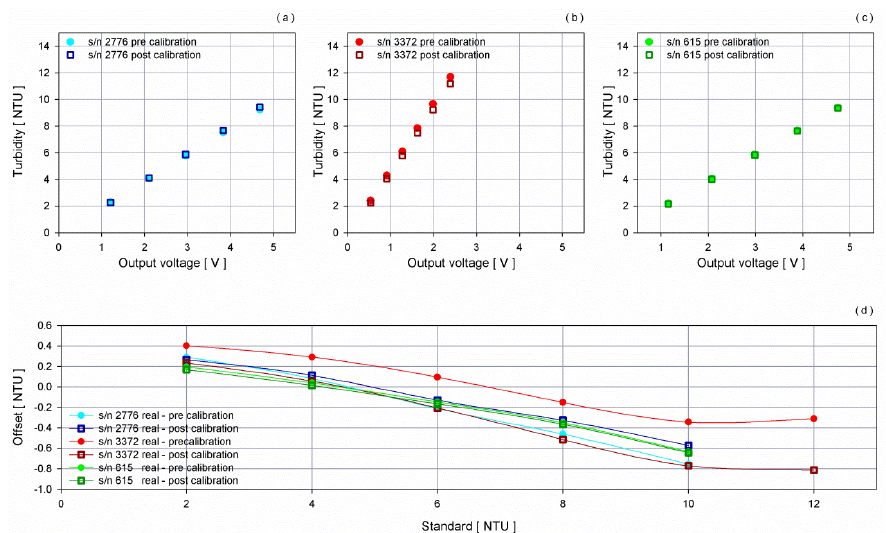
Figure 14. ( a – c ) Scatter plots of turbidity estimated by the three sensors before and after the experiment